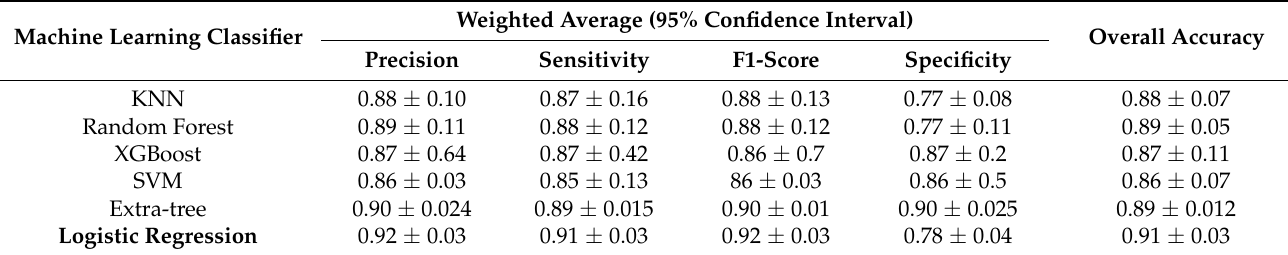
Table 3. Performance Comparison between different Machine Learning